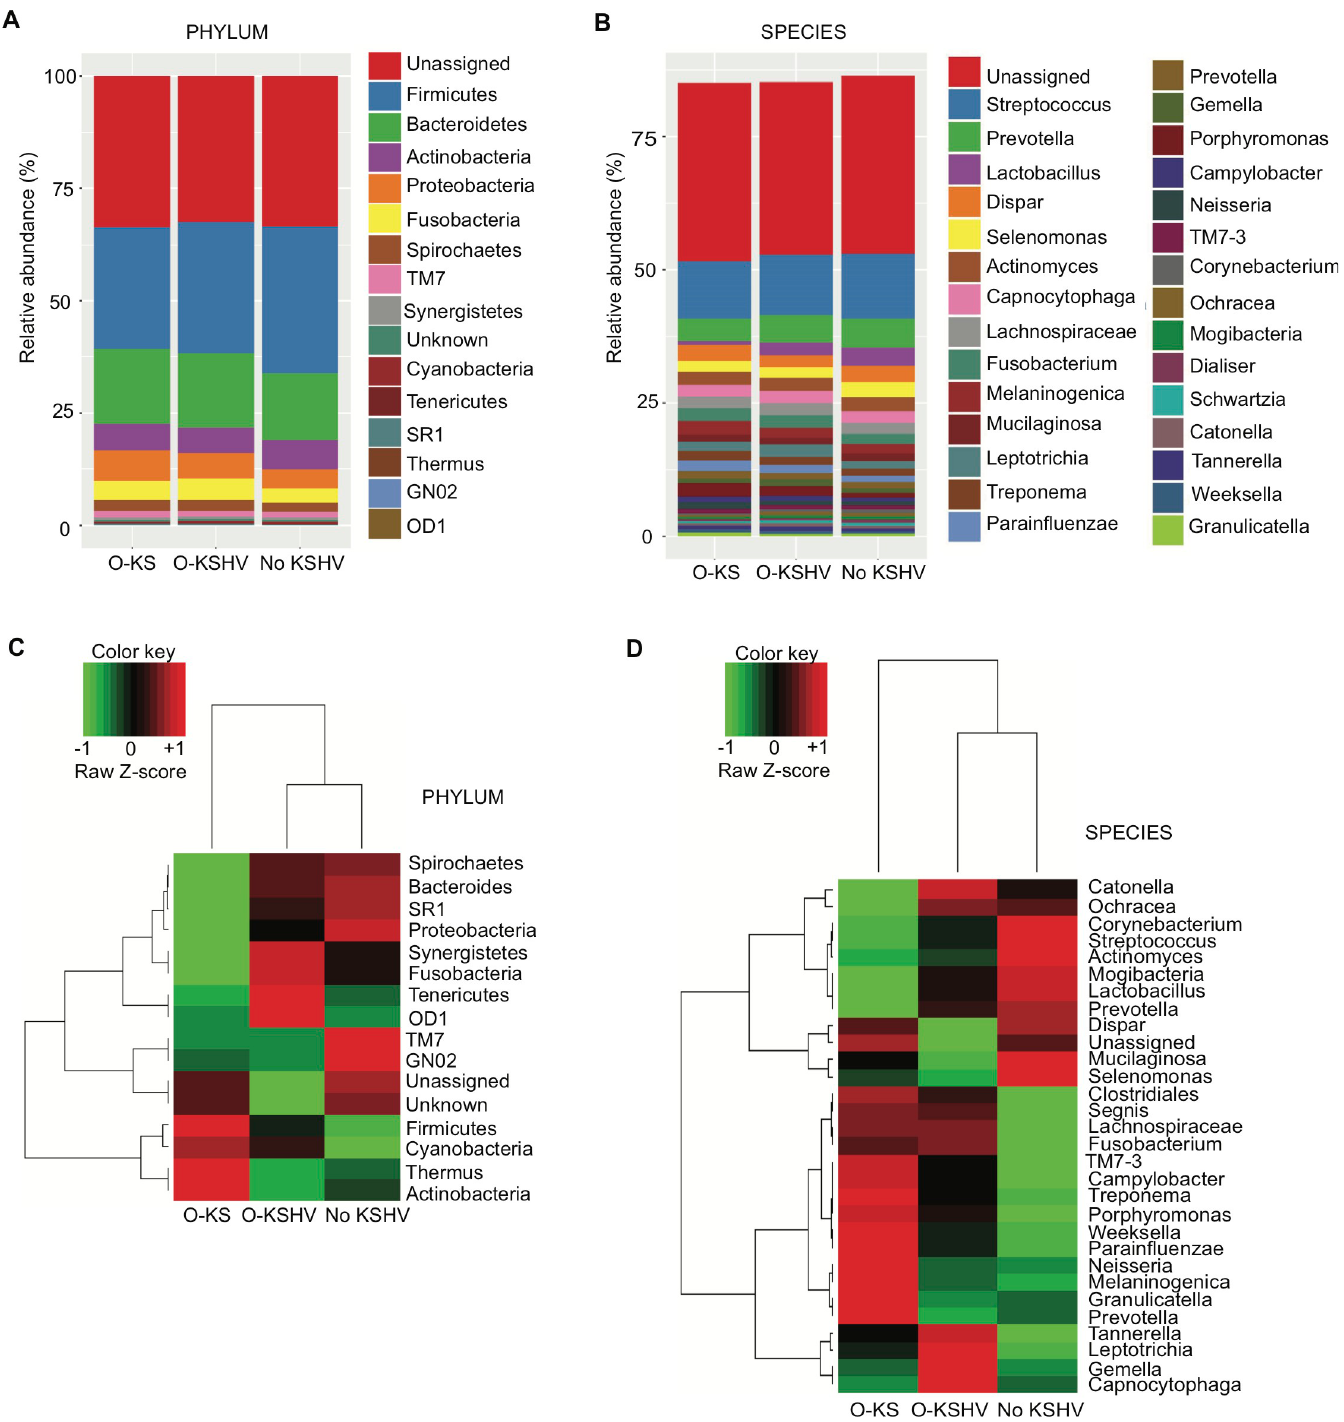
Fig 3. Relative abundances of OTUs and taxonomic compositions of bacterial communities at phylum and species levels in three studied groups of HIV/KSHV- coinfected individuals. (A) Mean of relative OTU abundances at phylum level for the three studied groups. (B) Mean of relative OTU abundances of the 30 most abundant species for the three studied groups. (C) Mean of the relative OTU abundances at phylum level clustered by the three studied groups. (D) Mean of the relative OTU abundances of the 30 most abundant species clustered by the three studied groups.